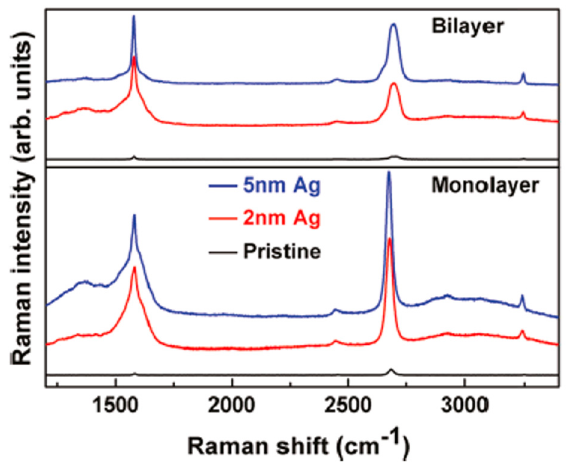
Figure 27. Raman spectra from monolayer and bilayer graphene on SiO 2 having deposited on the graphene 2 or 5 nm Ag film. Reproduced from Reference [71] with permission from the American Chemical Society.